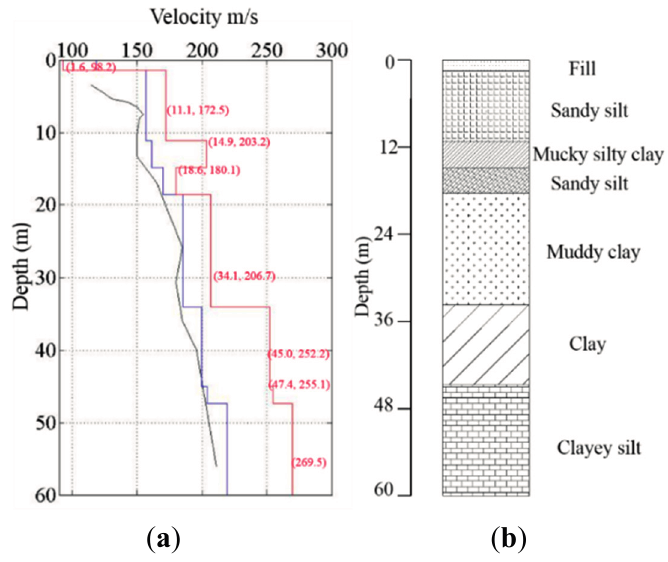
Figure 12. Shear wave profile of the test site: ( a ) shear wave velocity profiles; and ( b ) borehole soil profile. (The blue line is the initial shear wave velocity and the red line represents the final velocity